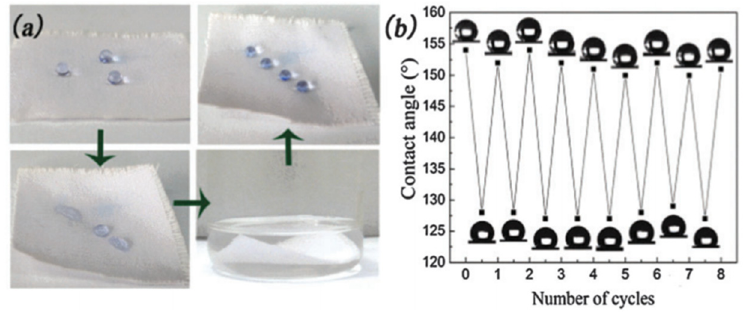
Figure 9. ( a ) Demonstration of self ‐ healing superhydrophobicity of the coated cotton fabric induced by acetone; ( b ) WCAs on the coated copper wire mesh in the eight cycles of 1 M HCl treatment [35].